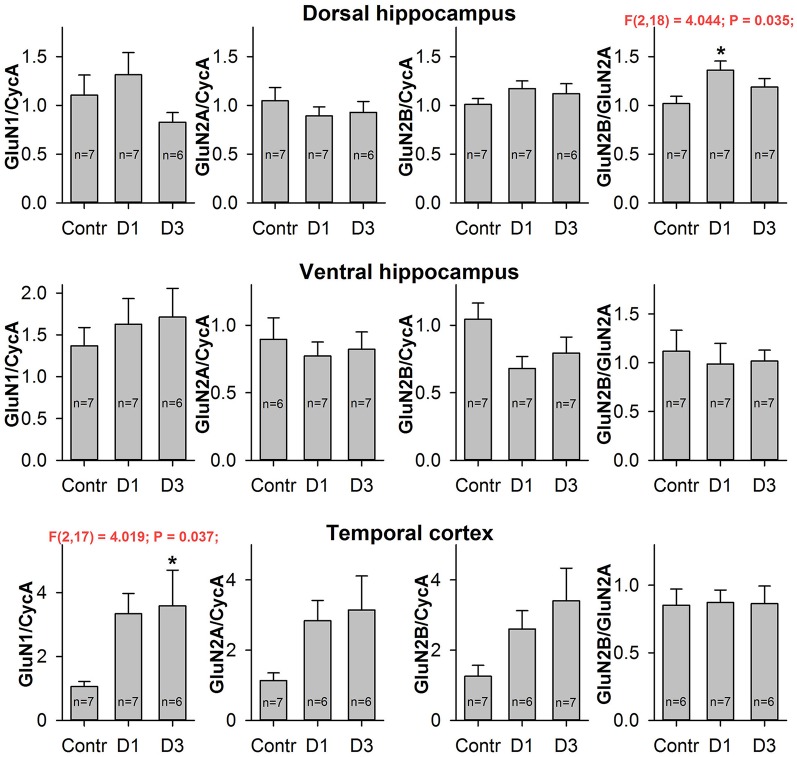
Quantitative real-time PCR analysis of NMDAR subunit mRNA. The mRNA expression of GluN1 subunits (first column), GluN2A subunits (second column), GluN2B subunits (third column) and GluN2B/GluN2A expression ratio (fourth column) in dorsal hippocampus (top), ventral hippocampus (middle), and temporal cortex (bottom) of control (Contr) and PILO- rats sacrificed in 1D – 24 h, 3D – 3 days after PILO administration. For datasets with detected significant differences, the corresponding one-way ANOVA results are presented in the chart. Asterisks (*) indicate significant difference (p < 0.05) from the control group (Dunnett's post hoc test, multiple comparisons vs. control group).